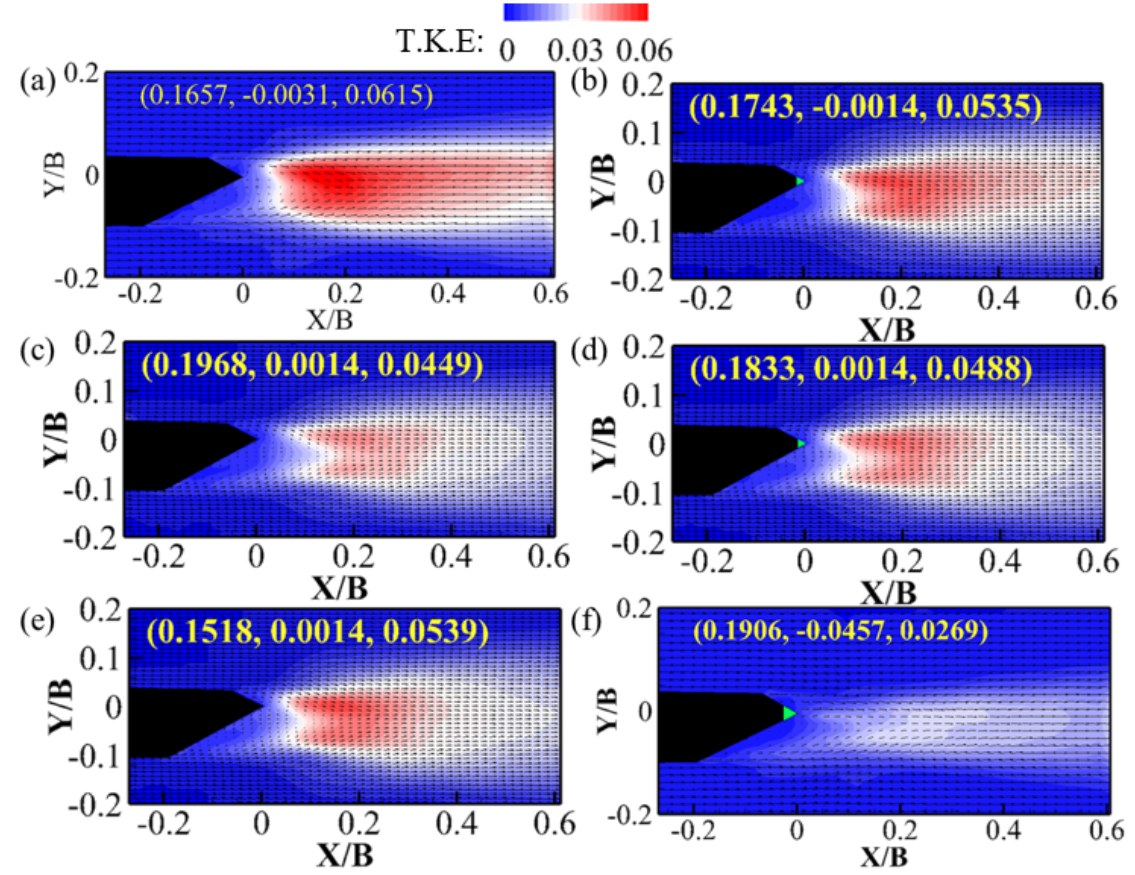
Figure 7. A time-averaged representation of the flow field behind SBG model. ( a ) J sj = 0, ( b ) J sj = 0.0016, ( c ) J sj = 0.0094, ( d ) J sj = 0.0409, J sj = 0.0802, and ( f ) J sj = 0.0094. ( a – e ): plane II, ( f ): plane I.